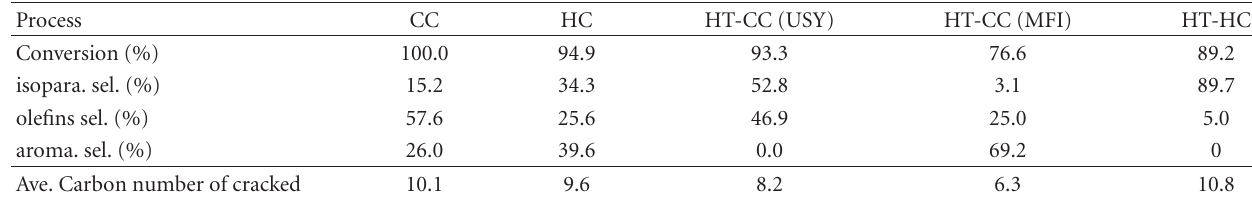
Table 3: Comparison of catalytic performance in various processes.